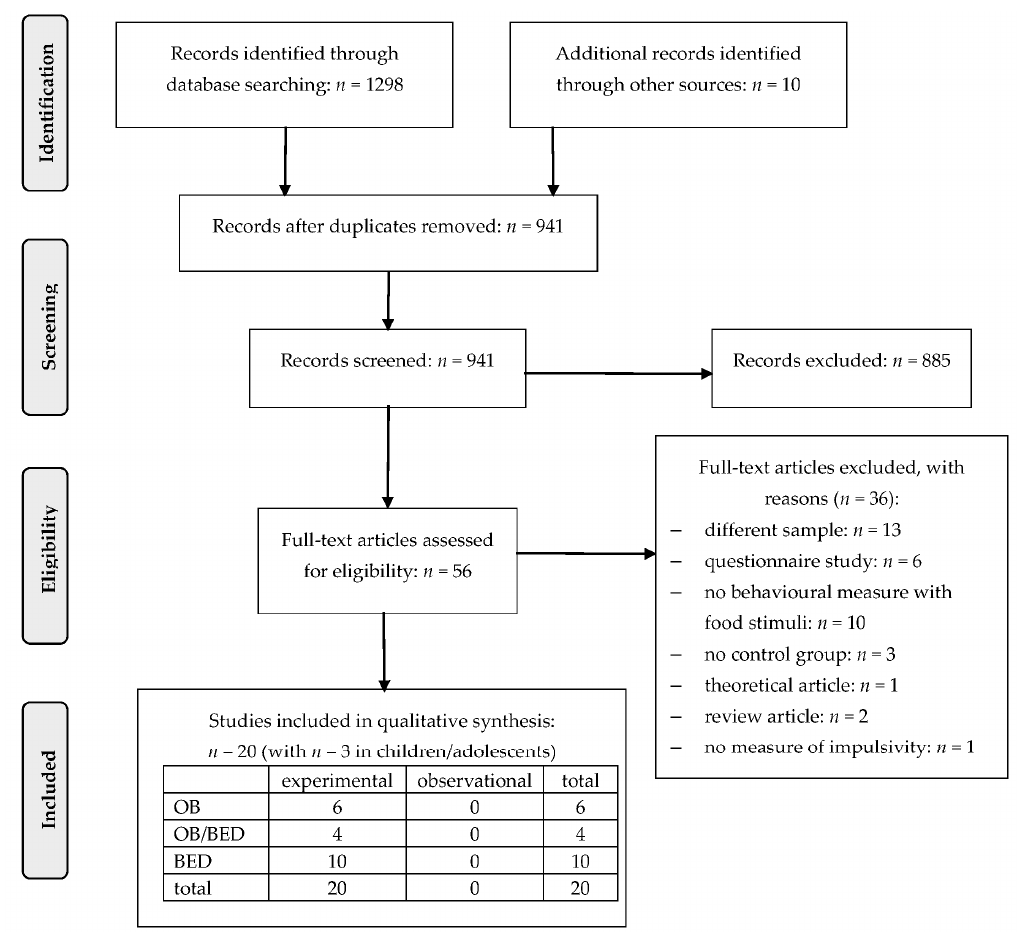
Figure 1. PRISMA (preferred reporting items for systematic reviews and meta-analyses) [21] flow chart for study inclusion. OB: obese sample; OB/BED: mixed sample; BED: sample with Binge Eating Disorder.